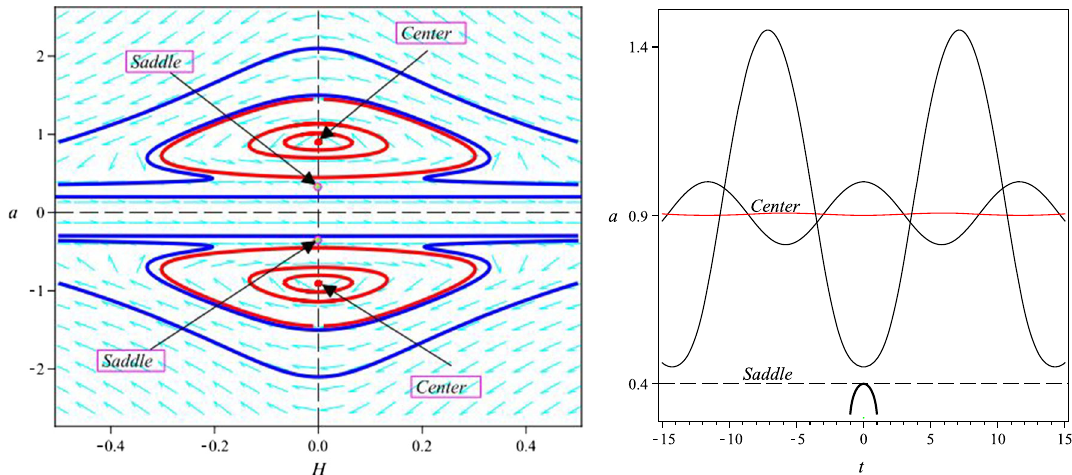
Fig. 1 (Left) dynamical behavior of the system around the critical points. (Right) time evolution of the scale factor a corresponding to the trajectories in phase space for the case of γ = 0, k = 1, α = 1 and β = 0 . 05